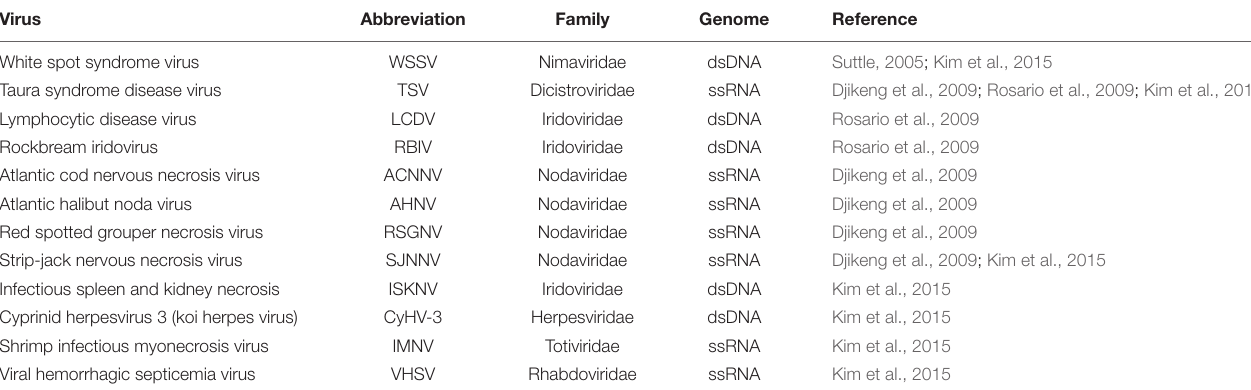
TABLE 1 | Finfish and crustacean viruses detected by metagenomics in freshwater